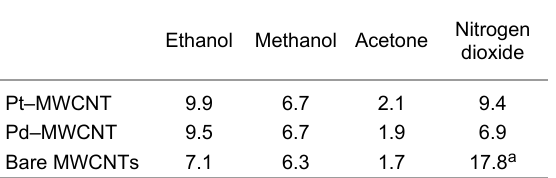
Table 2: Mean values of the sensitivity (10 − 2 % ppm − 1 ) to the different vapours and gasses tested for Pt–MWCNT, Pd–MWCNT and bare MWCNT